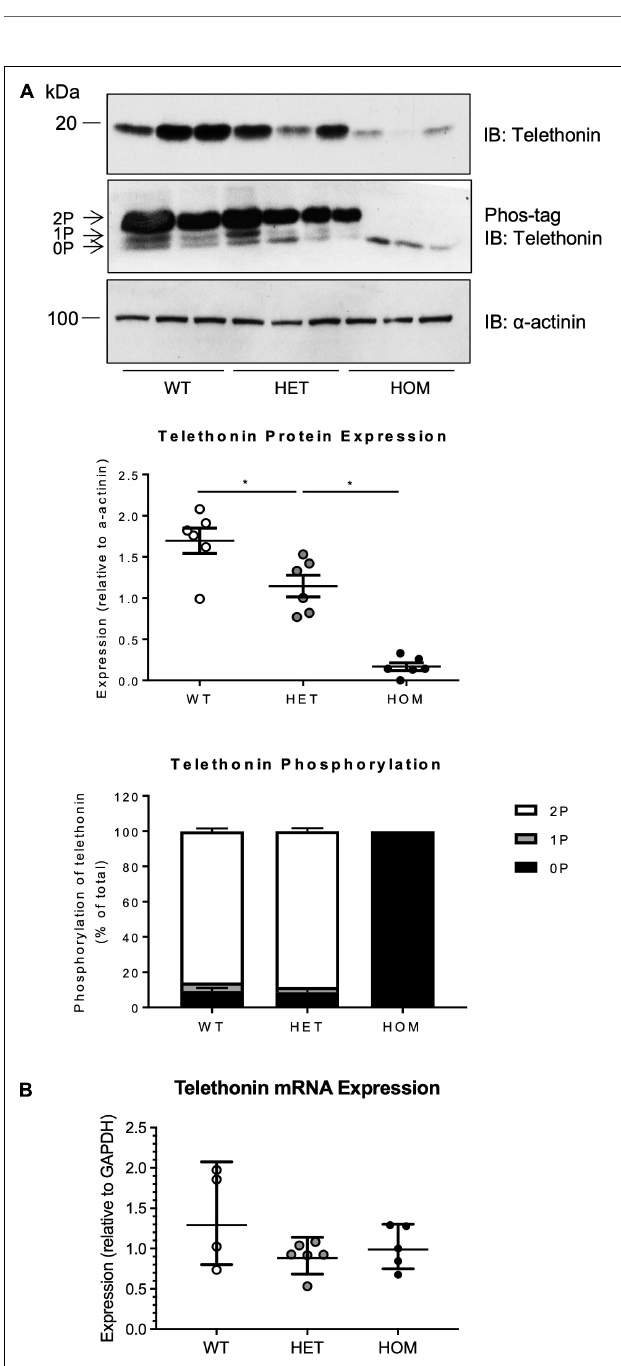
FIGURE 2 | Expression and phosphorylation of telethonin in Tcap S157 / 161A KI mice. (A) Cardiac homogenates from 16 week male mice subjected to SDS-PAGE (upper panel) and Phos-tag SDS-PAGE (middle panel) followed by immunoblotting. 2P, 1P, and 0P indicate bis-, mono-, and non-phosphorylated telethonin moieties. Densitometric analysis of telethonin protein expression normalized to α -actinin and densitometric analysis of telethonin phosphorylation normalized to the sum of the three phospho-moieties ( n = 6). (B) Real-time qPCR analysis of telethonin ( Tcap ) mRNA expression in cardiac tissue from 16 week old male mice ( n = 4–6) using the 2 − (cid:49)(cid:49) CT method ( Gapdh used as a reference gene). Protein data expressed as mean ± SEM, mRNA data expressed as geometric mean ± geometric SD, * p ≤ 0.05; one-way ANOVA with Tukey’s post hoc